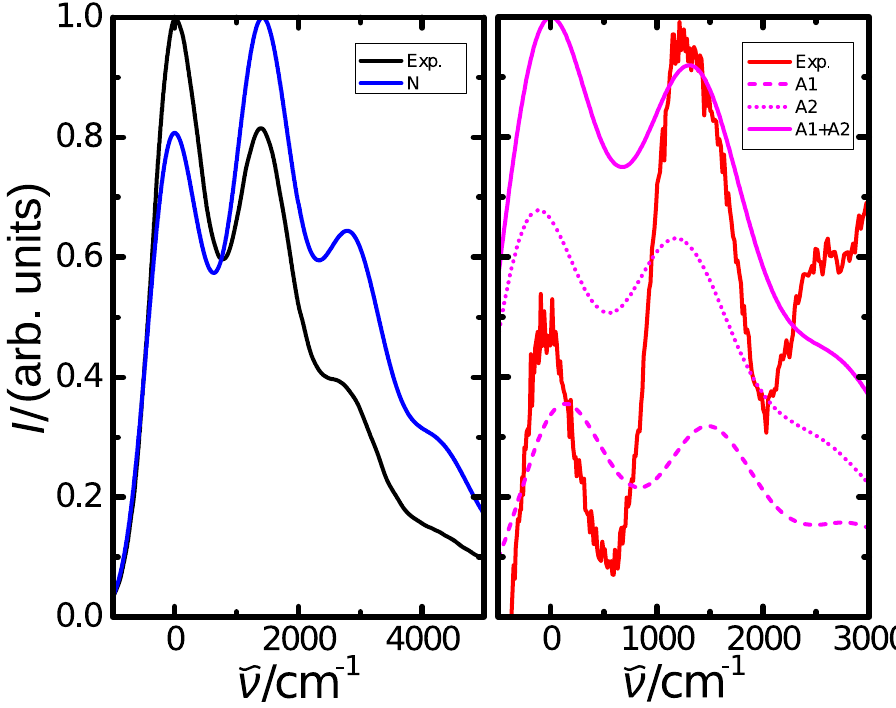
Figure 4. Lowest energy absorption band of the neutral molecule and simulated vibronically-resolved absorption spectrum for N. The energies, by which the spectra are shifted, were set to 21,412 cm − 1 and 21,350cm − 1 for the experimental and simulated spectra, respectively. Absorption in the infrared region found